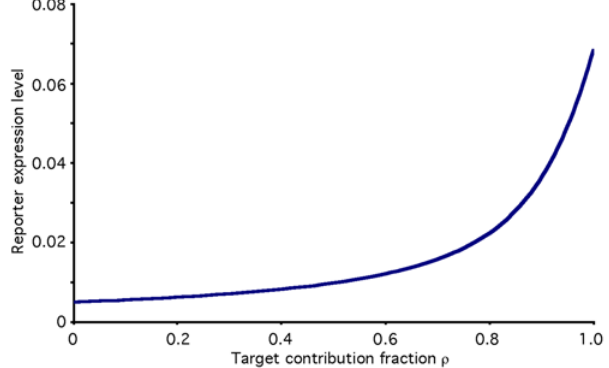
Figure 8. Targeting non-essential components. Graph shows level of reporter expression during recursive RNAi targeting compo- nents as a function of the degree to which the component is required for RNAi, indicated by requirement parameter rho. The equation describing this situation is derived in Materials and Methods. Graph plotted for c